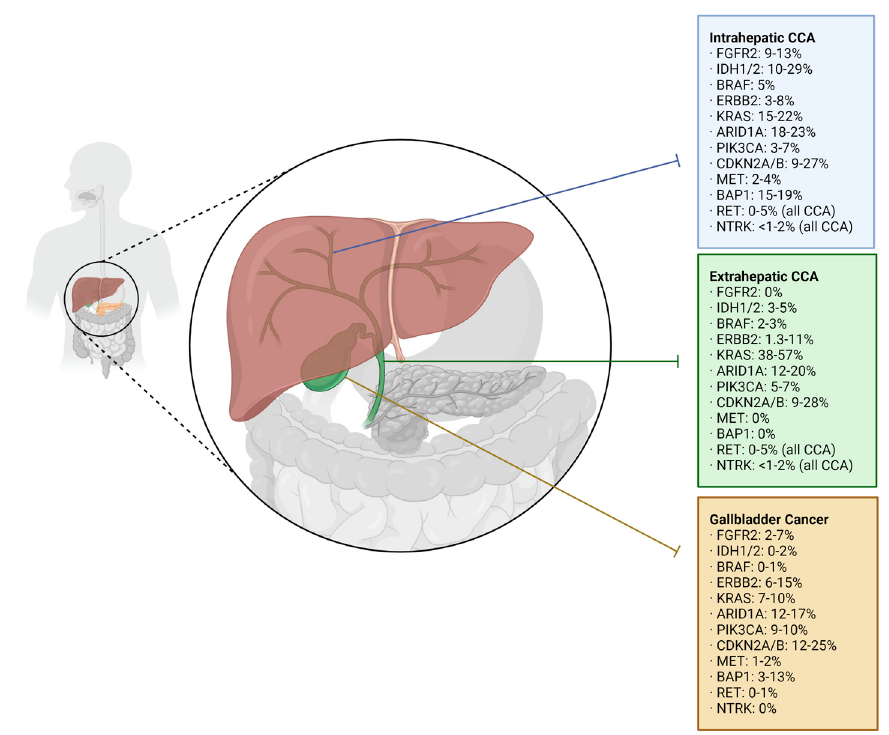
Figure 1. Prevalence of genomic aberrations by anatomic classification in cholangiocarcinoma